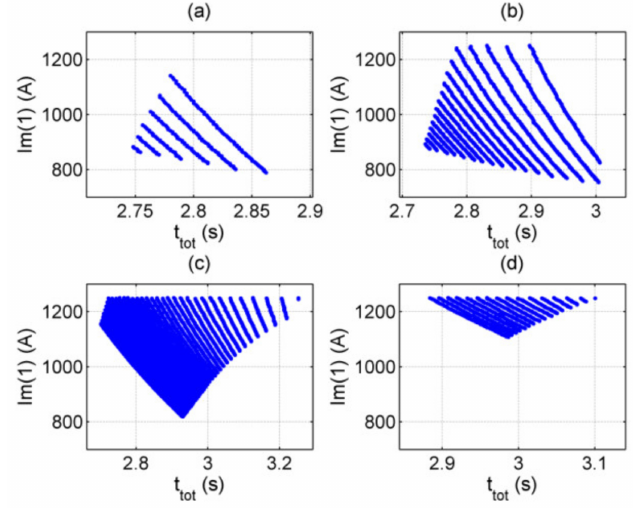
Figure 18. The relationship between the first peak value of the charging current and the total charging time for the four battery pack structures in the feasible solutions of the Enumeration algorithm, respectively. ( a ) N = 35. ( b ) N = 25. ( c ) N = 14. ( d ) N = 10.